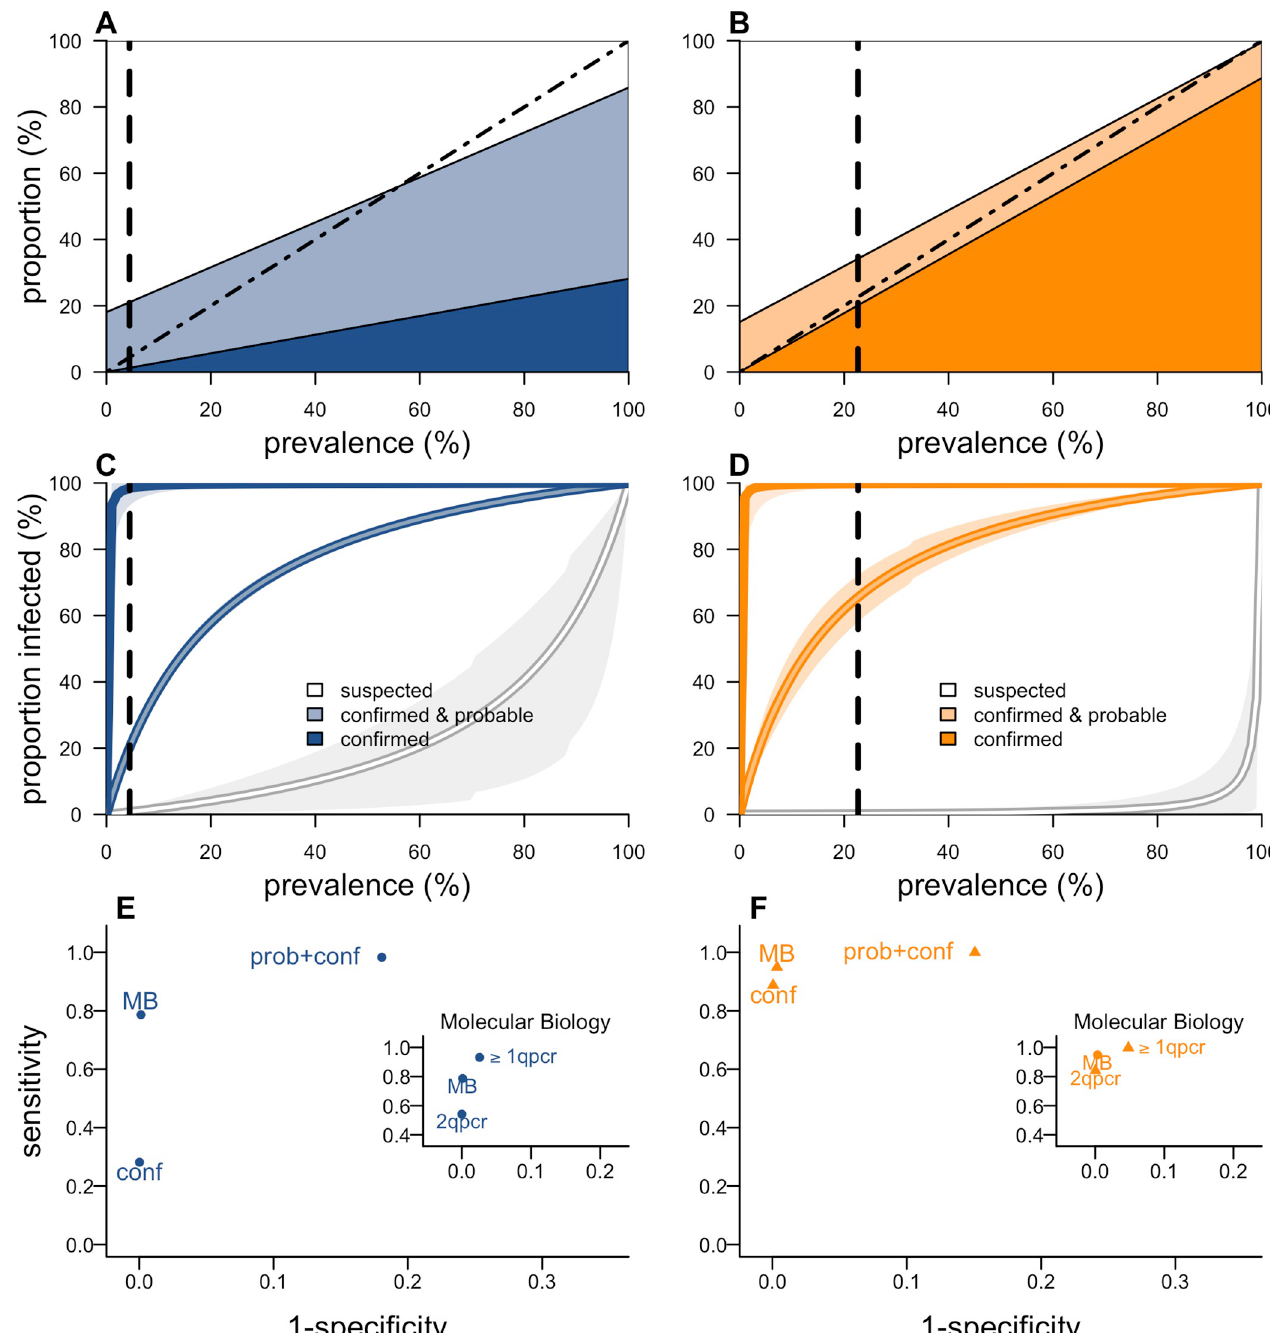
Fig 4. Performance of the case classification system. (A, B) Expected proportion of notified cases classified as confirmed (dark blue or orange), probable (light blue or orange), and suspected (white), as a function of prevalence of infection for PP (A) and BP (B). The dashed vertical line indicates the prevalence among notified cases estimated during the 2017 Madagascar outbreak. The dashed diagonal line corresponds to perfect classification (C, D). Expected proportion of Y . pestis infections among cases in the category confirmed, confirmed or probable, and suspected as a function of prevalence of infection for PP (C) and BP (D). (E, F) ROC plots presenting sensitivity versus (1-specificity) for a range of possible classification criteria for PP (E) and BP (F) and for simplifications of the MB algorithm for PP (inset of E) and BP (inset of F). MB is considered here due to its potential for being considered as a classifier by itself. Here, conf denotes confirmed and prob denotes probable. Classifications � 1 qpcr and 2 qpcr represent results based on qPCR solely, i.e., in the absence of confirmatory cPCR, with � 1 qpcr denoting “at least 1 gene positive” and 2 qpcr “both genes positive.” The underlying data and code to reproduce this figure are available on Open Science Framework (https://osf.io/nbc4t/). BP, bubonic plague; cPCR, classical polymerase chain reaction; MB, molecular biology; PP, pneumonic plague; qPCR, quantitative polymerase chain reaction; ROC, Receiver operating characteristic.